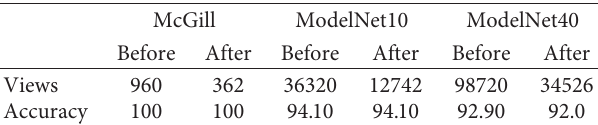
Table 4: Views and classification accuracy (%).